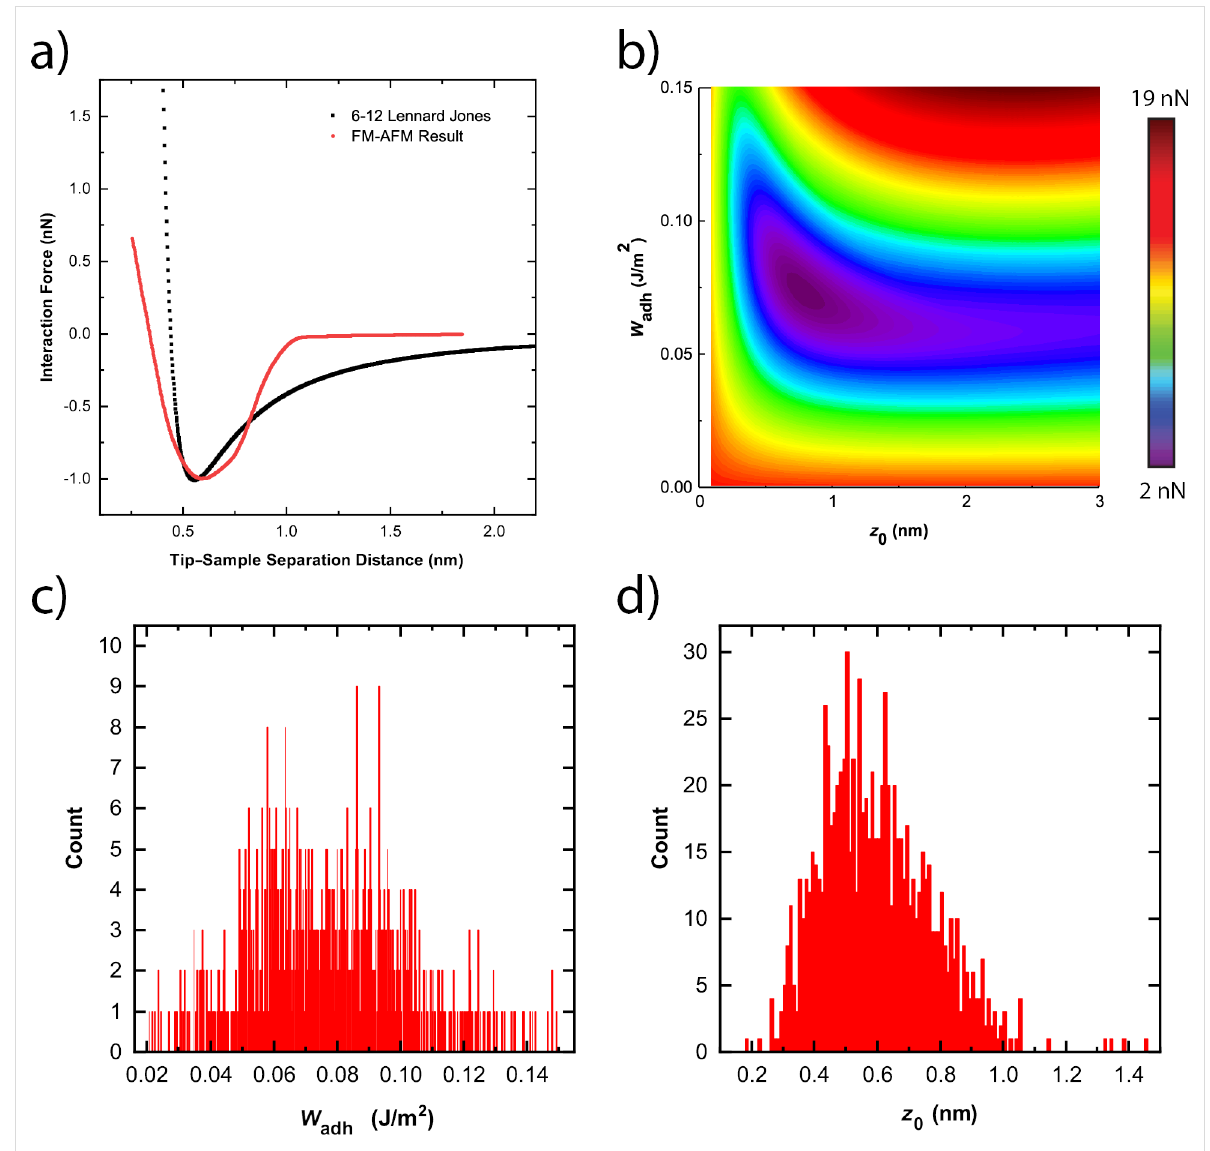
Figure 5: (a) Example of an experimentally derived interaction force–distance curve compared to a theoretically derived force–distance curve with best-fit parameters for W adh and z 0 . Theoretical LJ F ( z ) curves were calculated using a tip apex profile generated by TEM images taken before the AFM experiments. In this case, the best-fit parameters for W adh and z 0 are 0.0860 J/m 2 and 0.55 nm, respectively. (b) An example of a square-rooted variance map produced using a least squares fitting technique to compare the experimental F ( z ) curves to LJ F ( z ) curves. (c, d) Histograms of the best-fit W adh and z 0 values, respectively, over the entire diamond